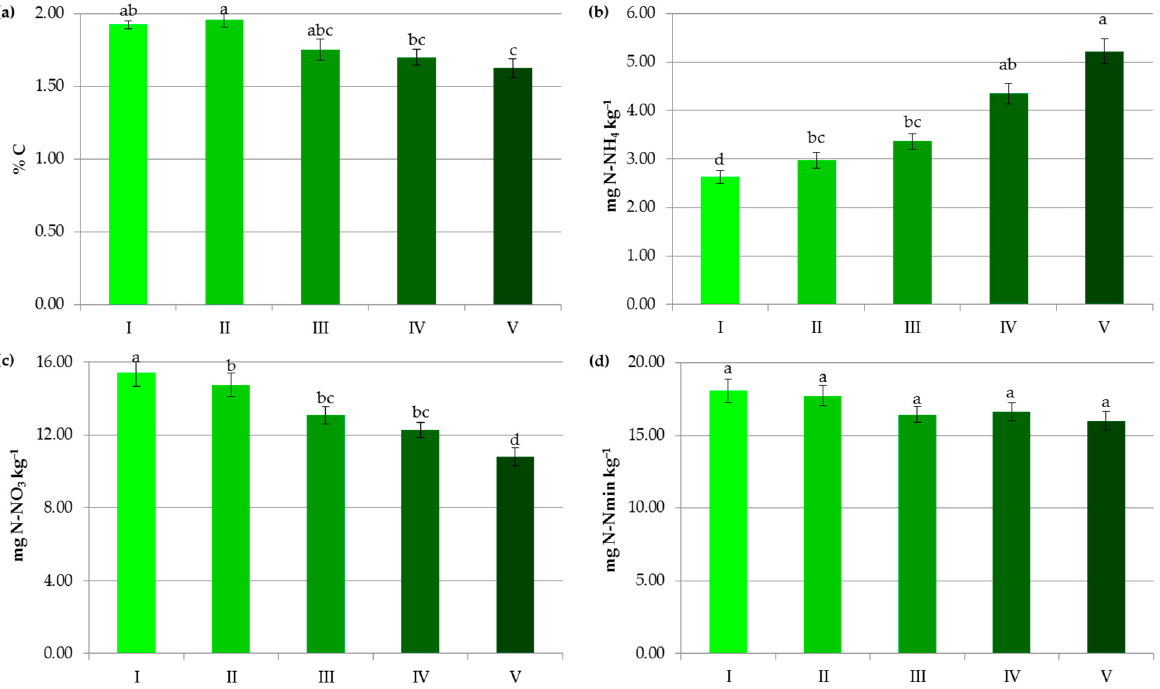
Figure 3. Impact of soil pH on contents of organic carbon ( a ), ammonium nitrogen ( b ), nitrate nitrogen ( c ) and mineral nitrogen ( d ). I—alkaline soils, II—neutral soils, III—slightly acidic soils, IV—acidic soils, V—highly acidic soils. The same letter means not significantly